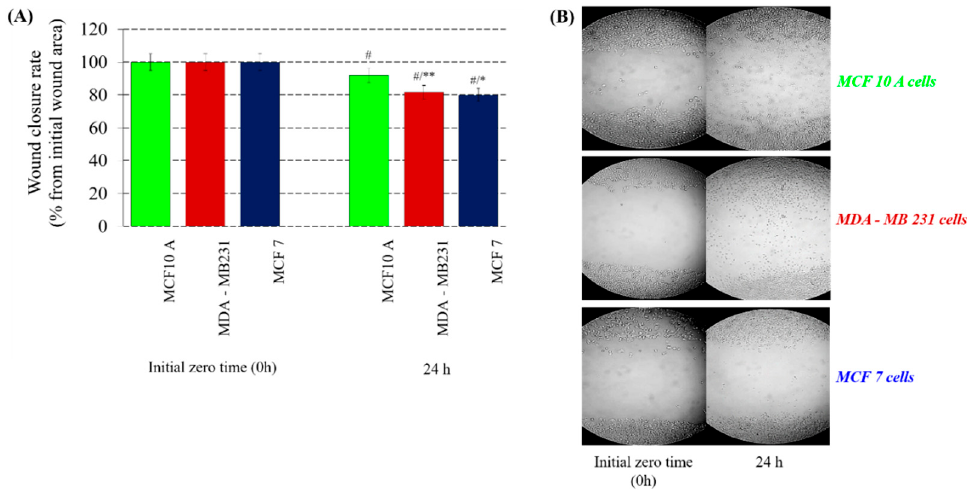
Figure 2. ( A ) Wound closure rate of breast normal/cancer cells 24 h after treatment with subcytotoxic concentration TL (75 µ M), analyzed by CytoSelect ™ —wound healing (WH) assay. Calculated wound area of MCF10A normal cells (green columns), high-metastatic MDA-MB231 cell line (red columns) and low-metastatic MCF7cell line (blue columns) are presented as a percent of initial wound area at the initial zero time. All data are the means ± SD from two independent experiments and three independent calculations via ImageJ software; * p < 0.05 versus MCF10A normal cells, ** p < 0.01 versus MCF10A normal cells; # p < 0.05—all variations versus corresponding controls are statistically significant. ( B ) Cell migration capacity of normal MCF10A cells (top panel) and cancer cells (high-metastatic MDA-MB231 cells—middle panel; low-metastatic MCF7 cells—bottom panel) after treatment with subcytotoxic concentration (WH assay). Images were obtained after 24 h incubation by phase-contrast microscopy, magnification 10 ×.